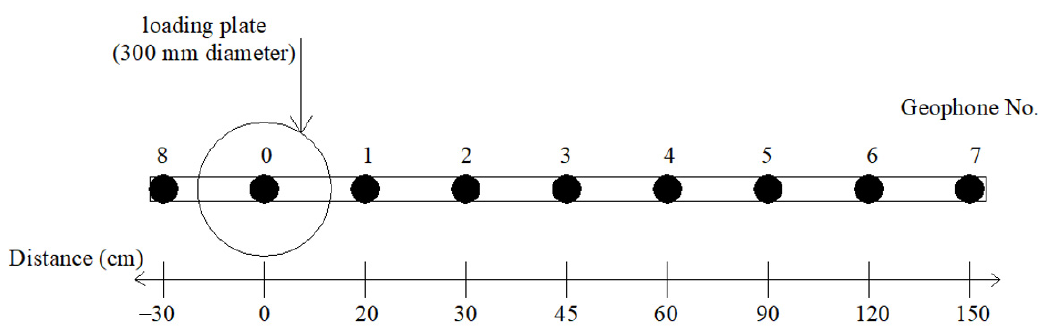
Figure 9. FWD geophone position.